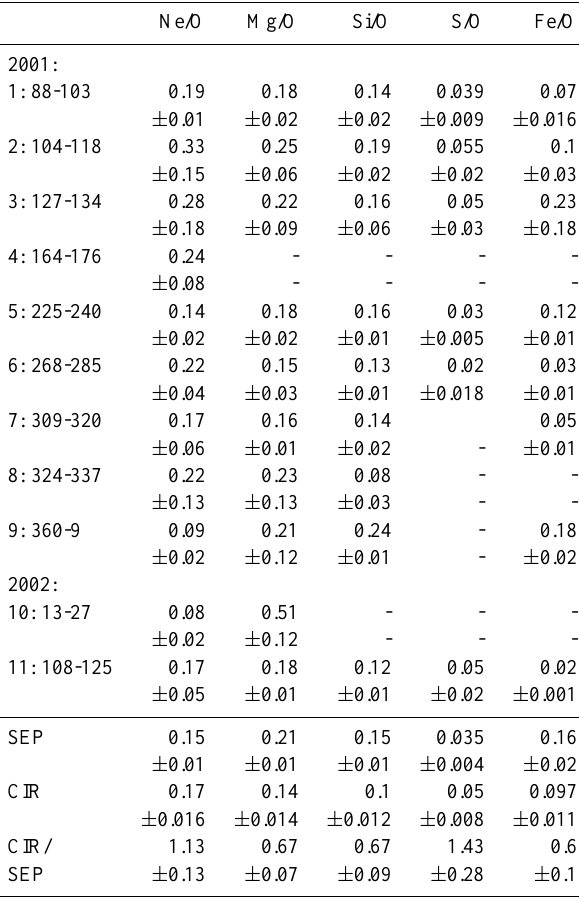
Table 1. The elemental abundance ratios averaged during 11 se- lected periods from the beginning of 2001 to day May in 2002 mea- sured by Ulysses COSPIN/LET in the lower energy range. The last six rows contain SEP and CIR values (Mason and Sanderson, 1999), the CIR/SEP ratios and their errors for comparison (He/O, C/O, N/O: 4 . 25–6 . 75 MeV/n; Ne/O, Fe/O: 5.5–7.5 MeV/n)